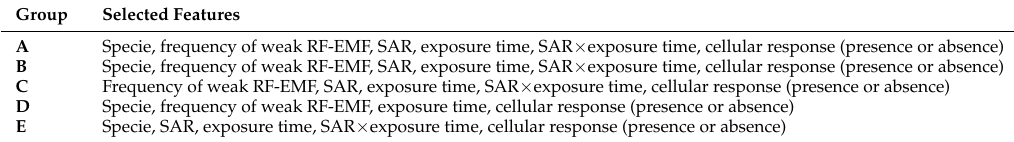
Table 5. Grouping or clustering strategies to allocate these selected features into five different laboratory experiment scenarios. This will produce five different feature groups or distributions for each laboratory